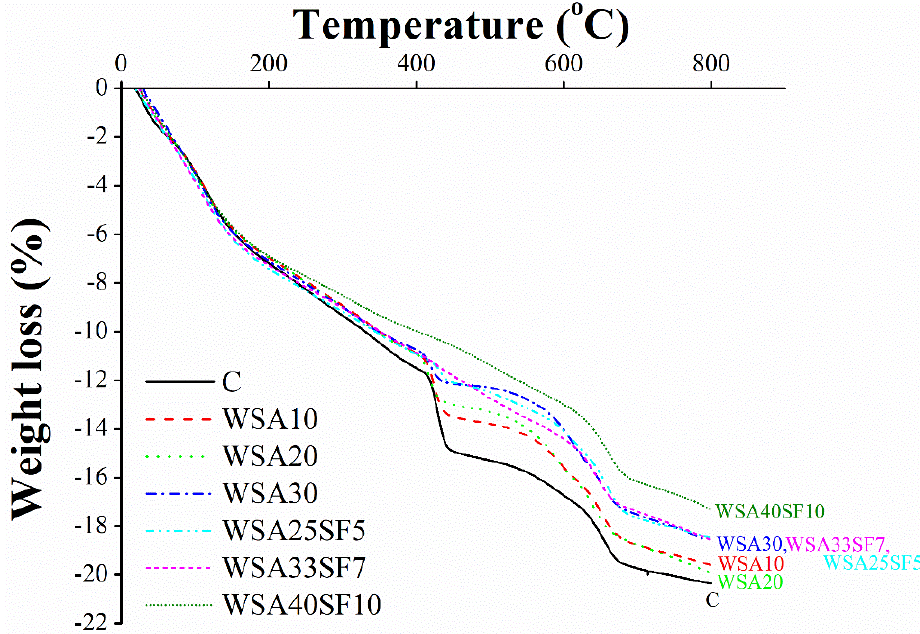
Figure 10. Comparison of thermogravimetric analysis of 91-day cured paste samples among control, binary (C/WSA), and ternary (C/WSA/SF) paste samples after 91 days of curing. Table 7. Actual amount of calcium hydroxide (C-H) and normalized with respect to the percent content of cement in each mix (C-H/OPC) after 91 days of cement